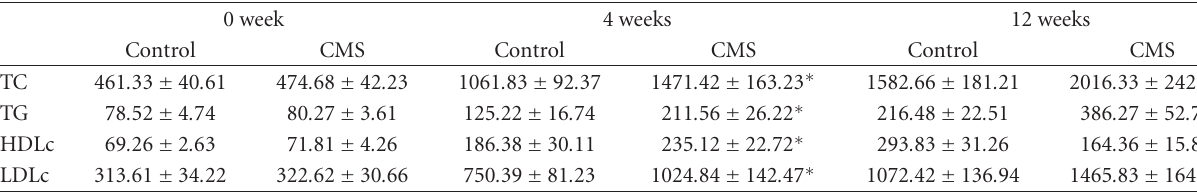
Table 1: E ff ect of CMS on plasma lipid levels of apoE-/- mice (mg/dL). Plasma lipid profiles in stressed and control mice were detected following 12-hour period of food and water deprivation at the week 12 ( n = 20 per group). Data are mean ± SEM.